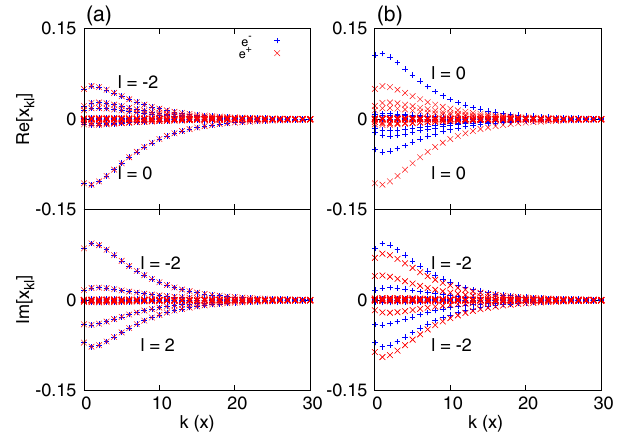
ð(cid:2)Þ FIG. 18. Eigenvector x for the two-beam mode at the kl ¼ 0 . 54 and (b) 0.96, as a function of k (a) horizontal tune ν x in FCCee-Z. The upper and lower plots are the real and imaginary parts of the eigenvector, respectively.